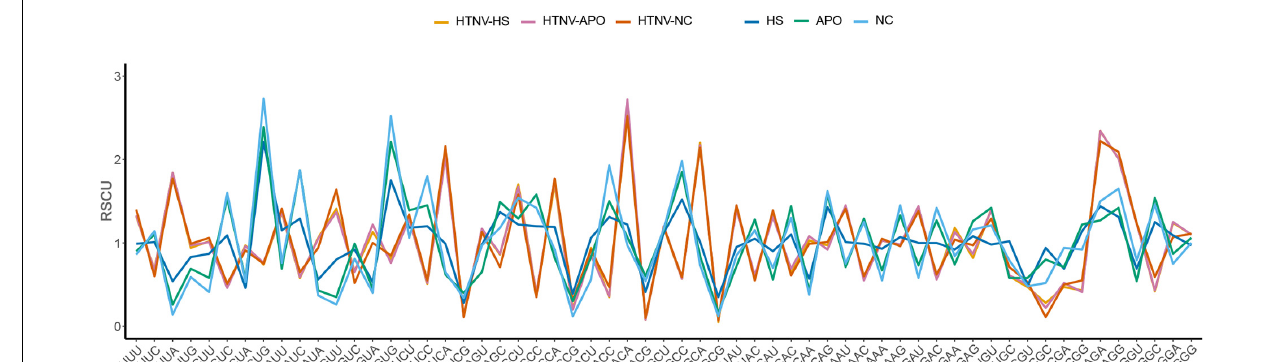
FIGURE 2 | RSCU patterns of HTNV strains (based on isolation host) with its relevant host and natural reservoirs.